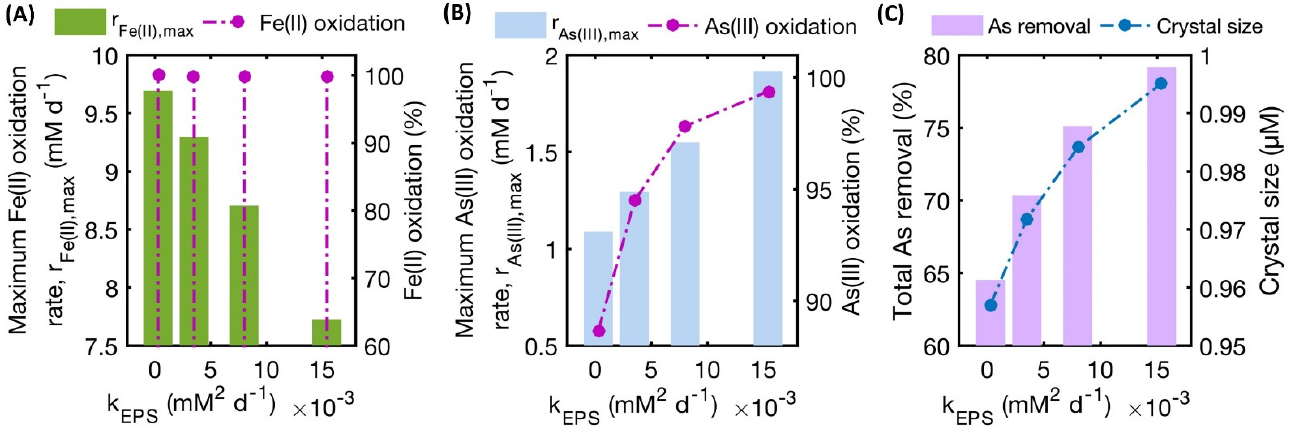
Figure 6. Effect of the oxidation rate constant for the EPS compartment (k EPS ) on the overall process, evaluated at 14-day culture operation ( A – C ).